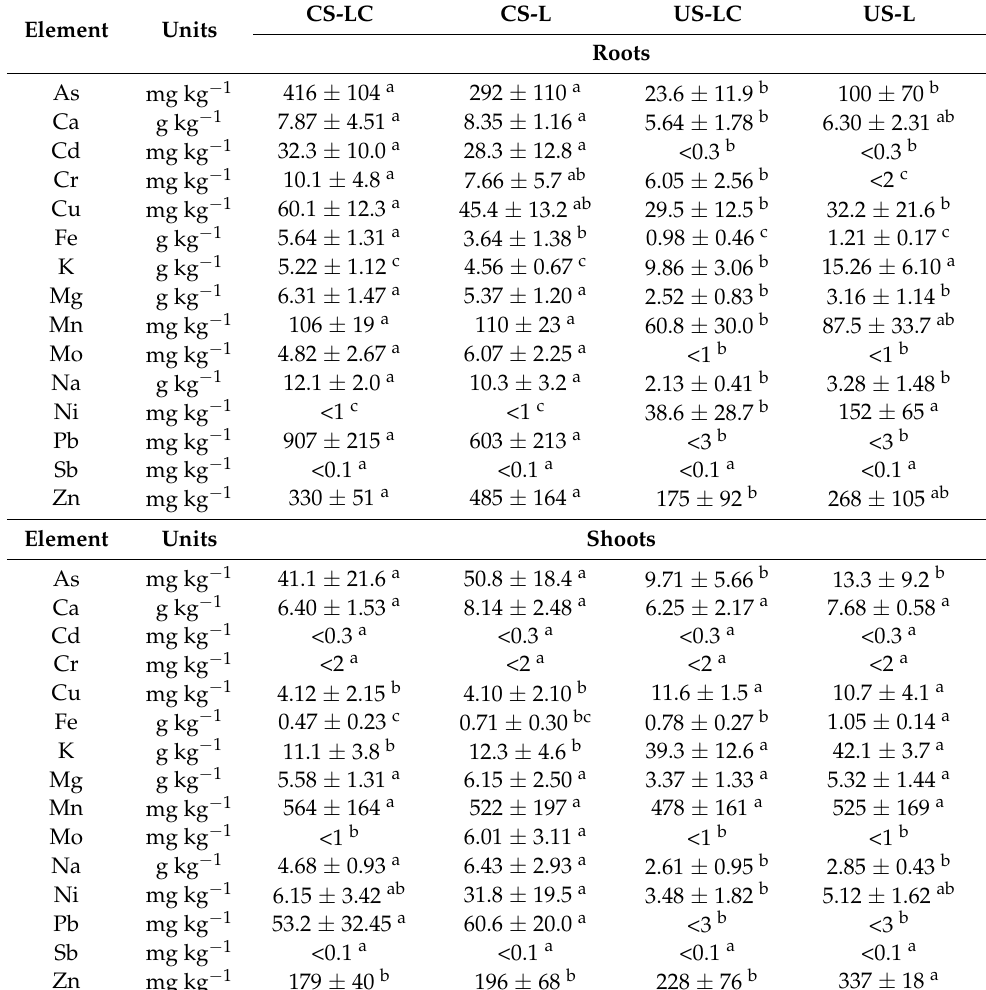
Table 2. Concentrations of metal(oid)s in roots and shoots of L. pedunculata from seeds collected in S ã o Domingos (LC) and Caldeir ã o (L) planted in the contaminated soil from S ã o Domingos (CS) and the uncontaminated soil from Caldeir ã o (US) ( n =